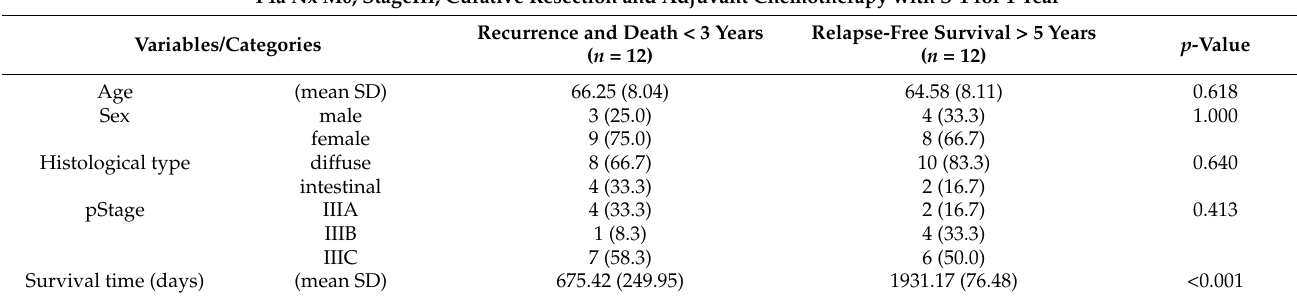
Table 2. Patients’ clinical data from proteomic